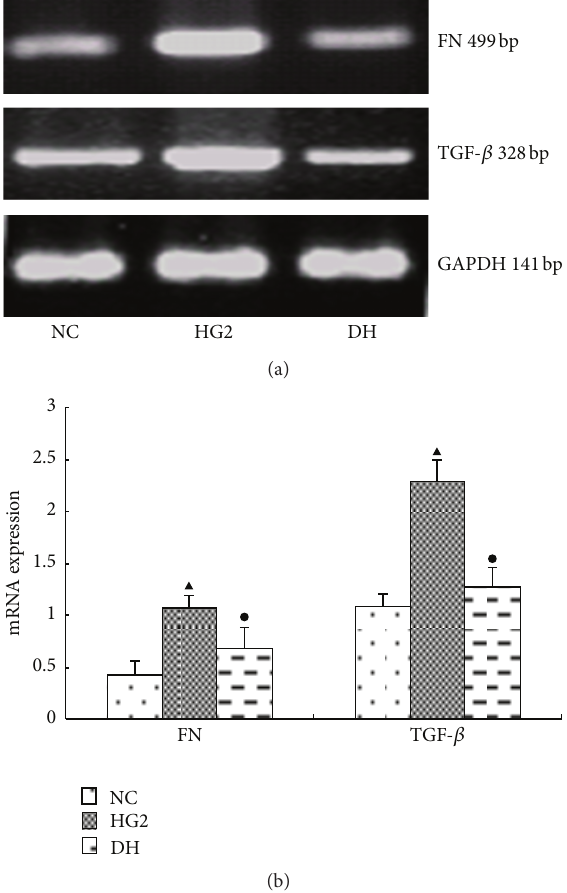
Figure 10: The expression of FN and TFG- 𝛽 after intervention with DAPT determined using PCR for 12hr. (a) RT-PCR strip chart for FN and TFG- 𝛽 . (b) The gray graph shows the relative statistical values for FN and TFG- 𝛽 in each group. Compared with the NC group, the expression of the FN and TFG- 𝛽 mRNA was significantly increased in the HG2 group. After DAPT intervention, the mRNA expression of FN and TFG- 𝛽 decreased. 󳵳 𝑃 < 0.05 versus NC group; ∙ 𝑃 < 0.05 versus HG2